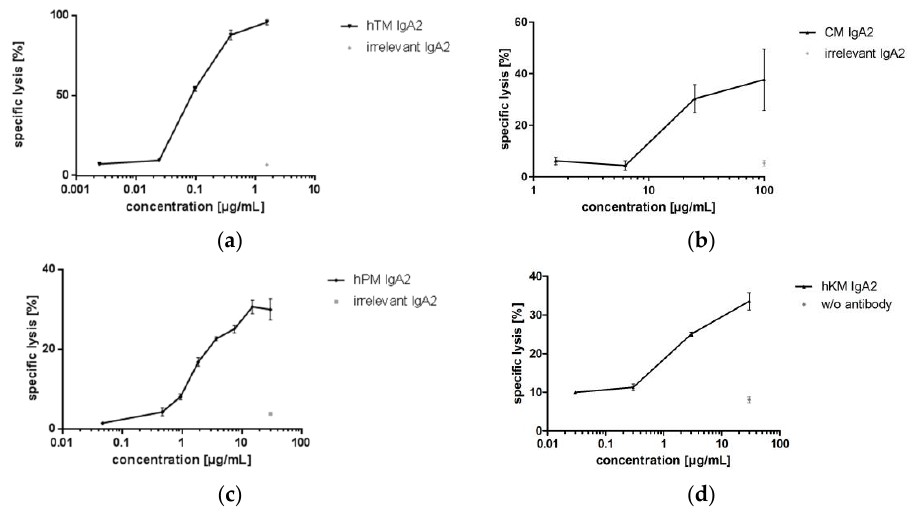
Figure 7. Antibody-dependent cellular cytotoxicity mediated by hTM, CM, hPM and hKM IgA2 antibodies against SK-BR-3, ZR-75-1 or Panc-1 target cells. Granulocytes isolated from peripheral blood were used as effector cells. Mean values (±SEM) of triplicates are shown. hTM ( a ) and CM IgA2 ( b ) mediated specific lysis of SK-BR-3 (Her2 +++, EGFR +) target cells. The irrelevant matched isotype control did not mediate lysis of SK-BR-3 target cells. hPM ( c ), and hKM IgA2 ( d ) mediated specific lysis of ZR-75-1 (TA-MUC1 +++) and Panc-1 (TF +) target cells, respectively. Antigen binding sites were determined using IgG antibodies and are indicated in brackets; antigen binding sites: +, 1 × 10 4 to 1 × 10 5 ; ++, 1 × 10 5 to 5 × 10 5 ; +++, >5 × 10 5 . One representative out of at least two independent experiments is shown.